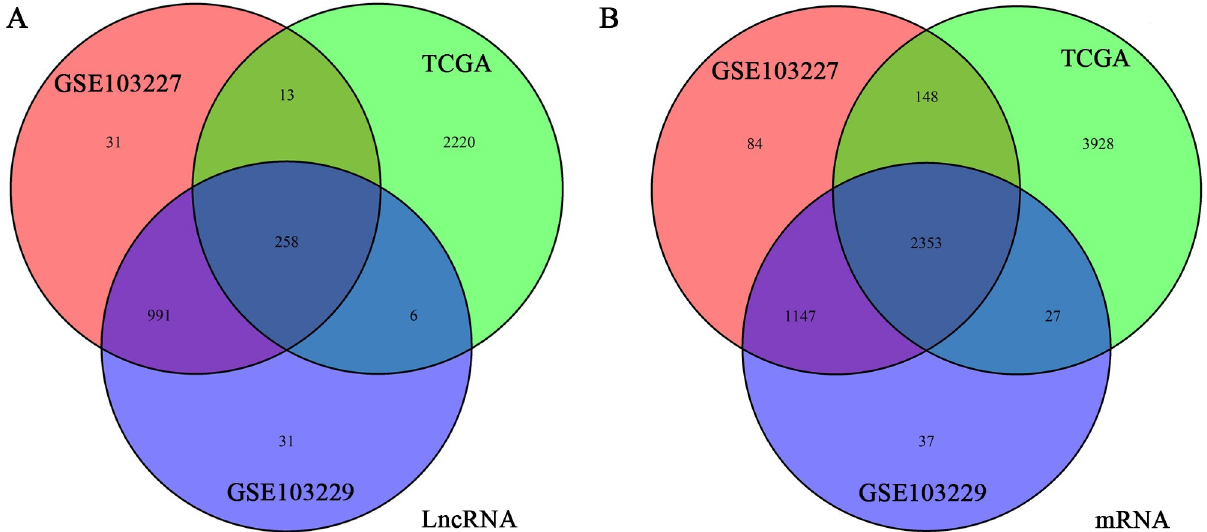
Fig 1. Acquisition of differentially expressed lncRNAs and miRNAs. (a, b) We obtained differentially expressed lncRNAs (a) and miRNAs (b) from the GSE103227, GSE103229, and TCGA databases. The Venn diagrams display the number of differentially expressed transcripts and the number of